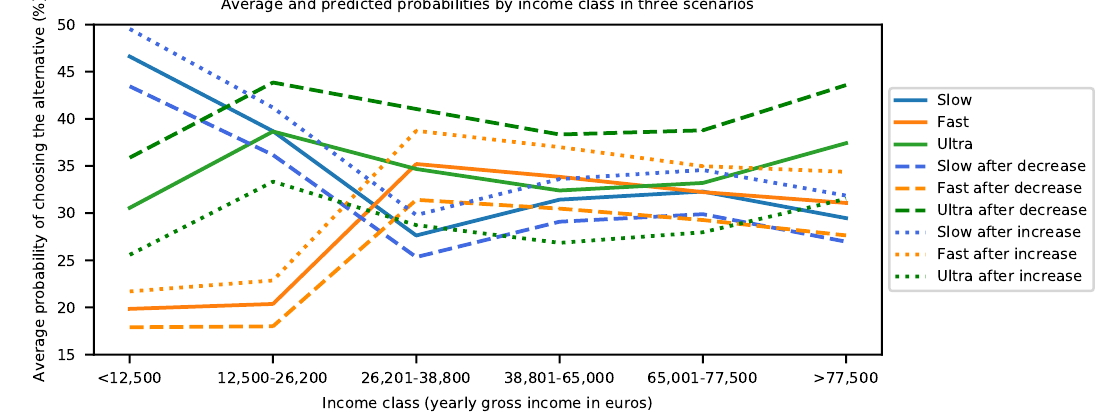
Figure 6. Probabilities per income class for scenarios with price changes for ultrafast charging. The scenarios include a 50% price decrease for ultrafast charging, the base scenario and a 50% price increase for ultrafast charging.